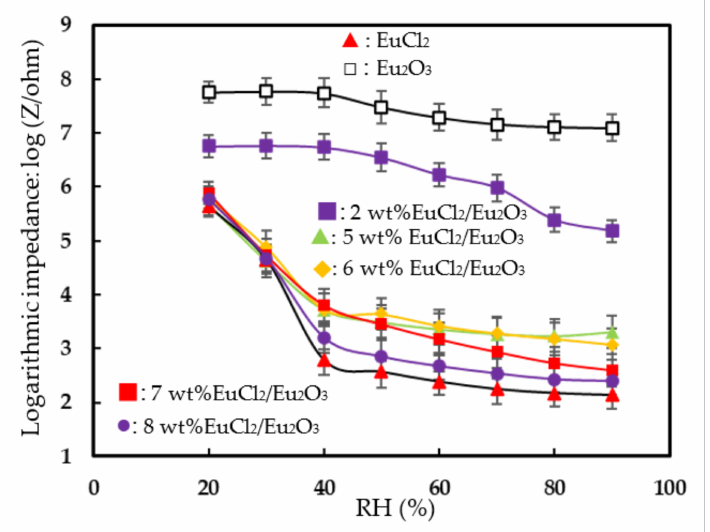
Figure 4. Log-impedance vs. relative humidity for humidity sensors based on EuCl 2 , Eu 2 O 3 and